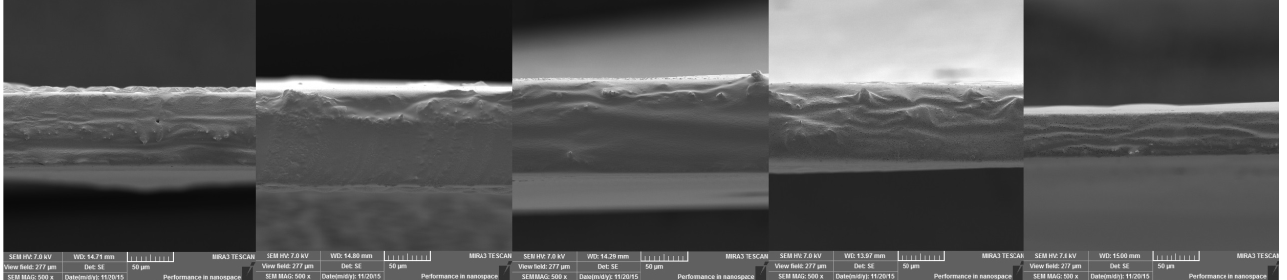
FIGURE 4 - Cross-sectional FE-SEM micrographs of FD10 in five different